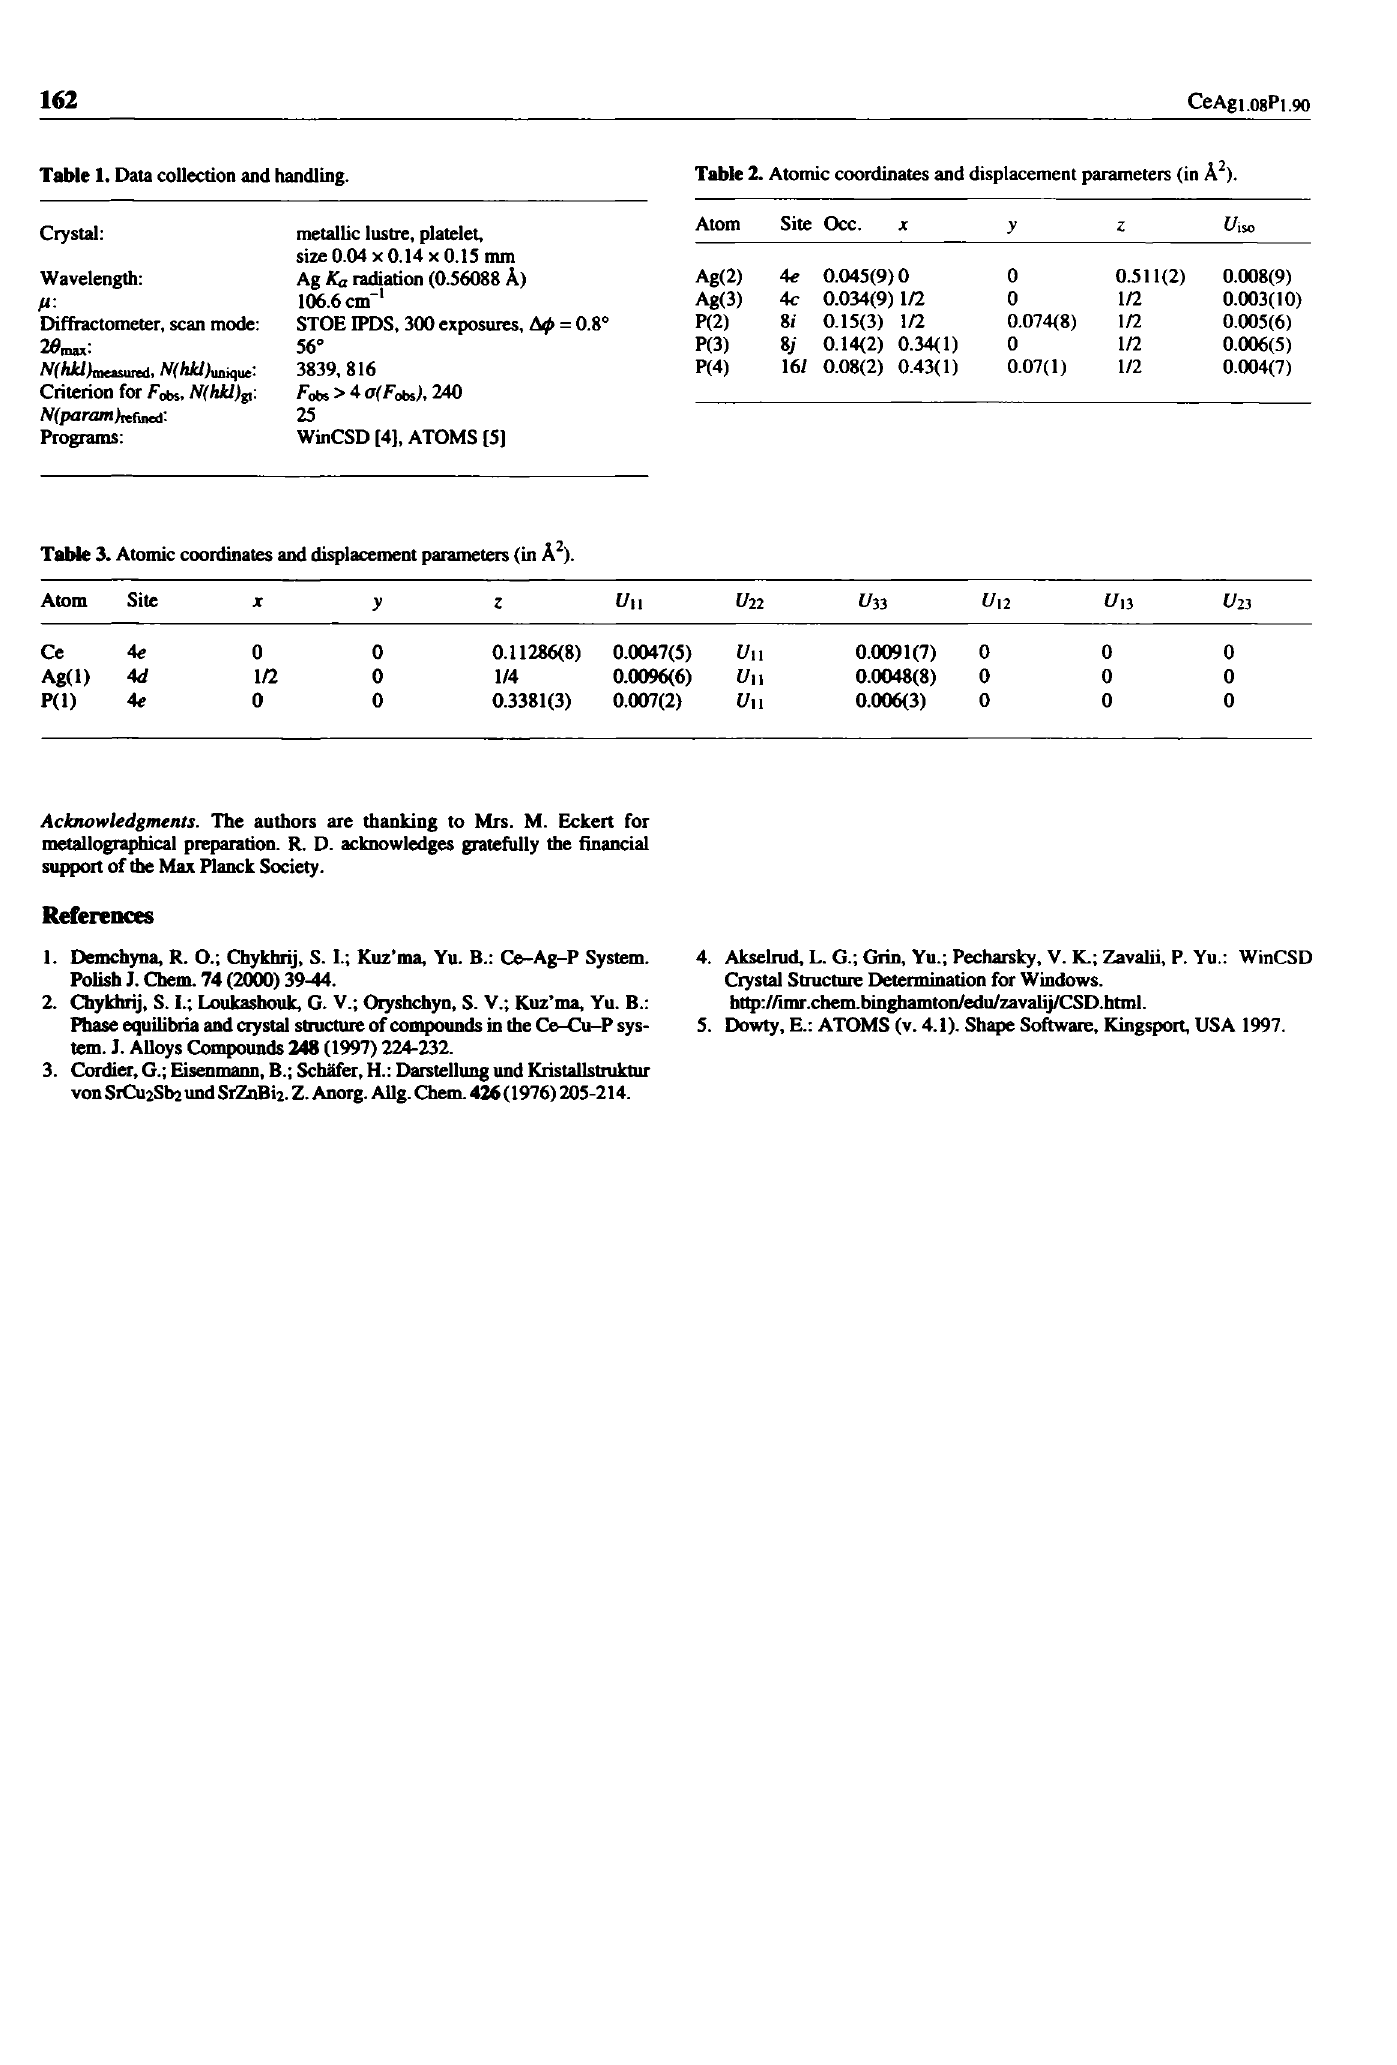
Table 3. Atomic coordinates and displacement parameters (in Â 2